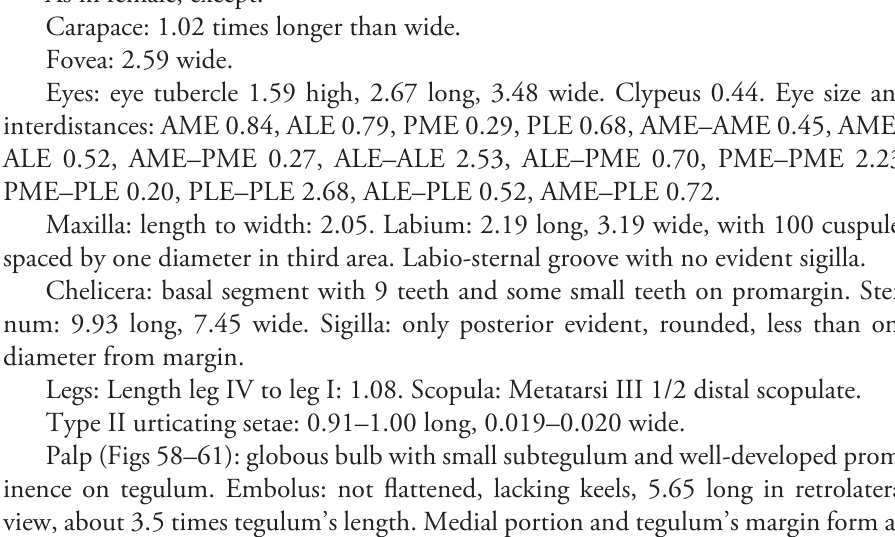
Legs: Length leg IV to leg I: 1.08. Scopula: Metatarsi III 1/2 distal